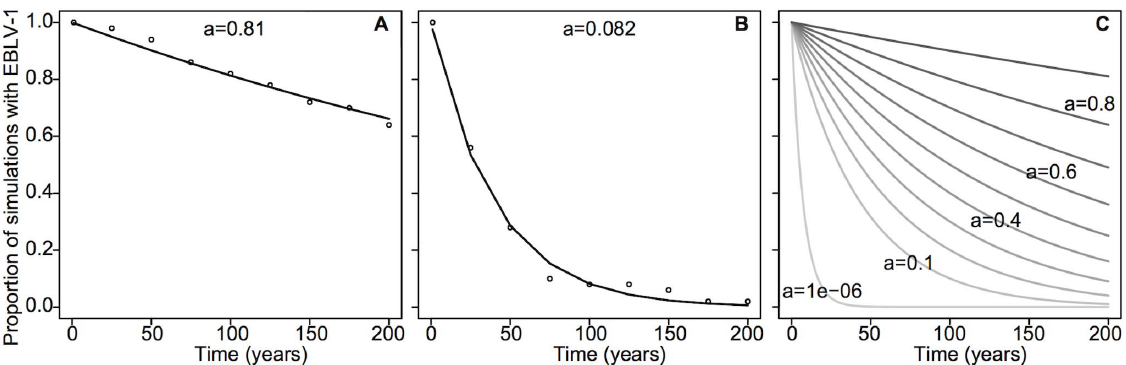
Figure 4. Virus persistence quantification. Fluctuations due to stochasticity cause virus extinction over long times. In order to study virus persistence, we defined the persistence index, a . For a given parameter set, we run the model 100 times and estimate a by fitting the function f ( t )= a (0.01 t ) to the decreasing proportion of simulations over time with virus persistence. (A, B) The decreasing proportion of simulations with EBLV-1 over time (circles) for two different parameter sets, and the corresponding fit of the function f ( t )= a (0.01) (black line). The persistence index a quantifies the probability of EBLV-1 persistence over time. A value of a =0.8 indicates that, after 100 years, EBLV-1 probability of persisting is 0.8. The parameter values used to generate the decreasing curves of simulations with virus persistence (corresponding to those in Mallorca) are the default values reported in Table 2, and for (A), R 0 =3, r =0.6 and interisland exchange =15 individuals, and for (B), R 0 =3, r =0.5 and interisland exchange =3 individuals. (C) f ( t ) over 200 years for ten reference values of the persistence